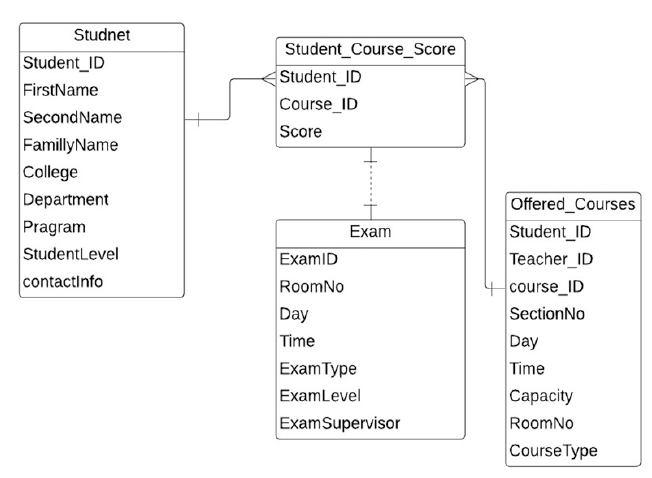
Figure A1. The ERD of the university registration office [31].